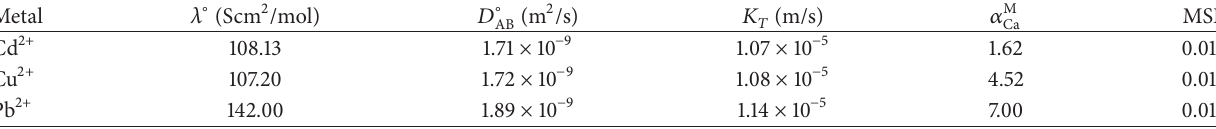
Table 3: External mass transfer and axial dispersion coefficients for heavy metal adsorption onto SCG.